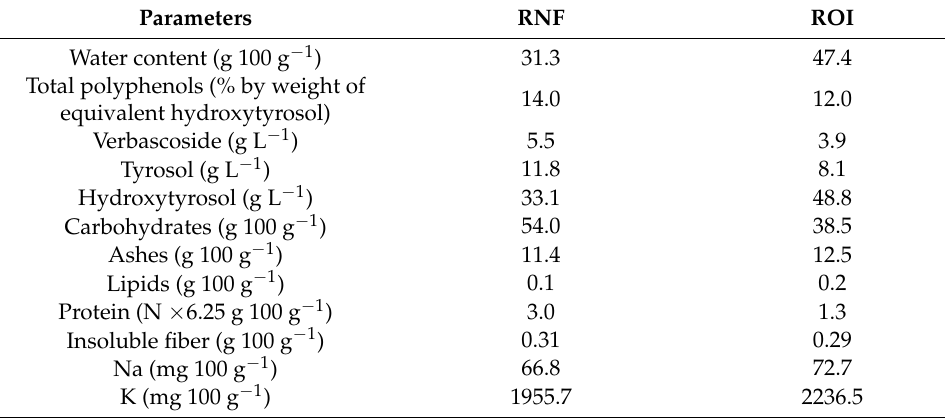
Table 2. Dry weight of the chemical compounds of retentates